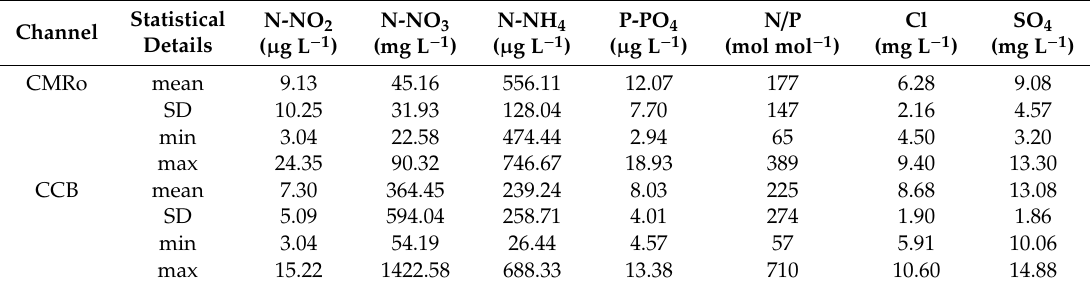
Table 2. Pore water analyses in sections of two navigation channels in Northeast France, the Canal from Champagne to Bourgogne (CCB) and the Canal from the Marne to the Rhine, Western Branch